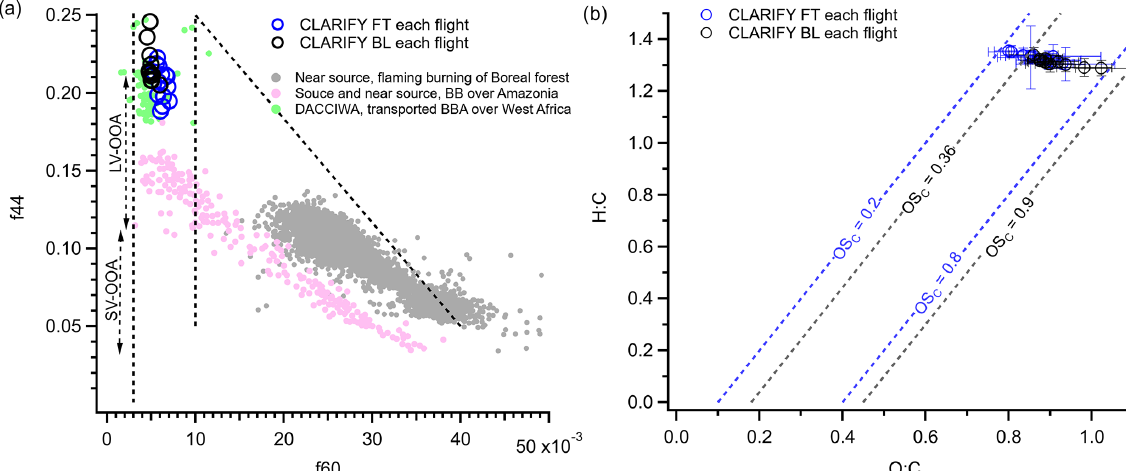
Figure 4. (a) The fractional signals f 44 vs. f 60 of BBA sampled in this and other studies. Blue and black markers represent the average of FT and BL BBA layers, respectively, for each flight. The vertical dashed grey line indicates the background of f 60 (0.3%) under non-BB conditions, as recommended by Cubison et al. (2011). (b) The average and standard deviation of H / C vs. O / C for sampled BBA in each flight and the boundaries of OSc in the BL (black) and FT (blue) respectively.